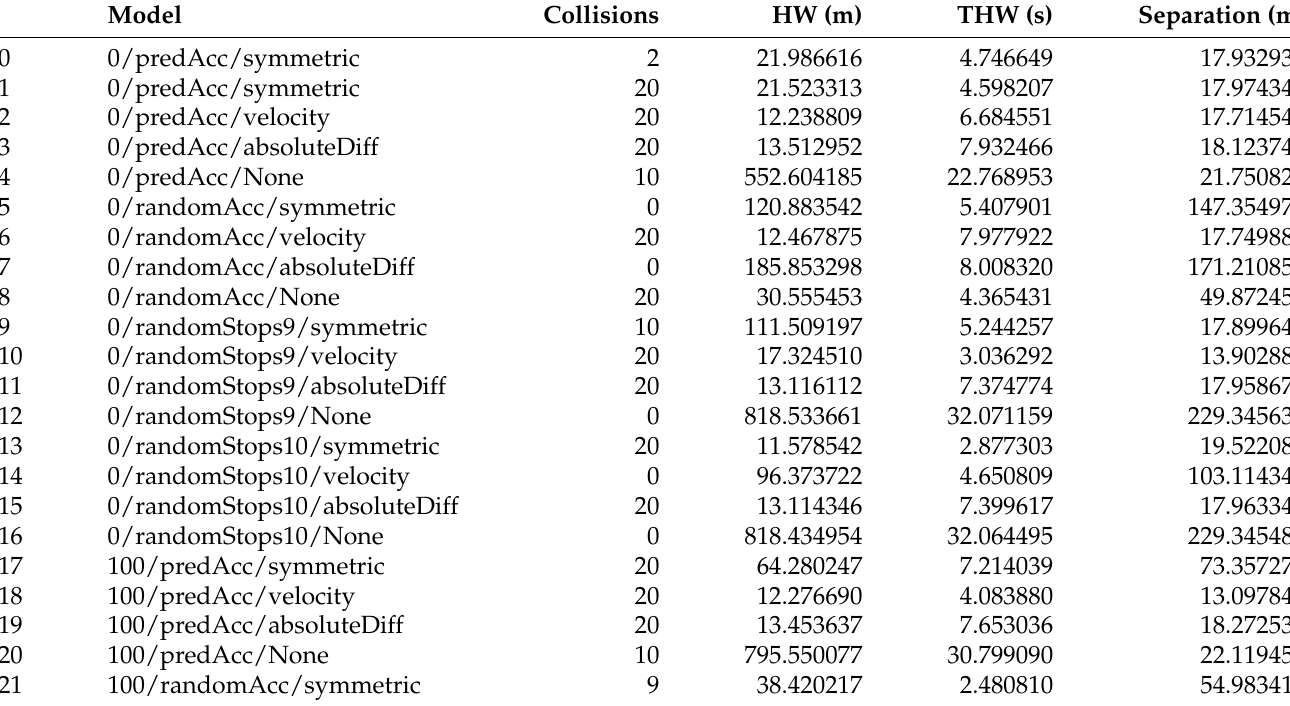
Table A1. Test results for the different combinations of parameters regarding the RL